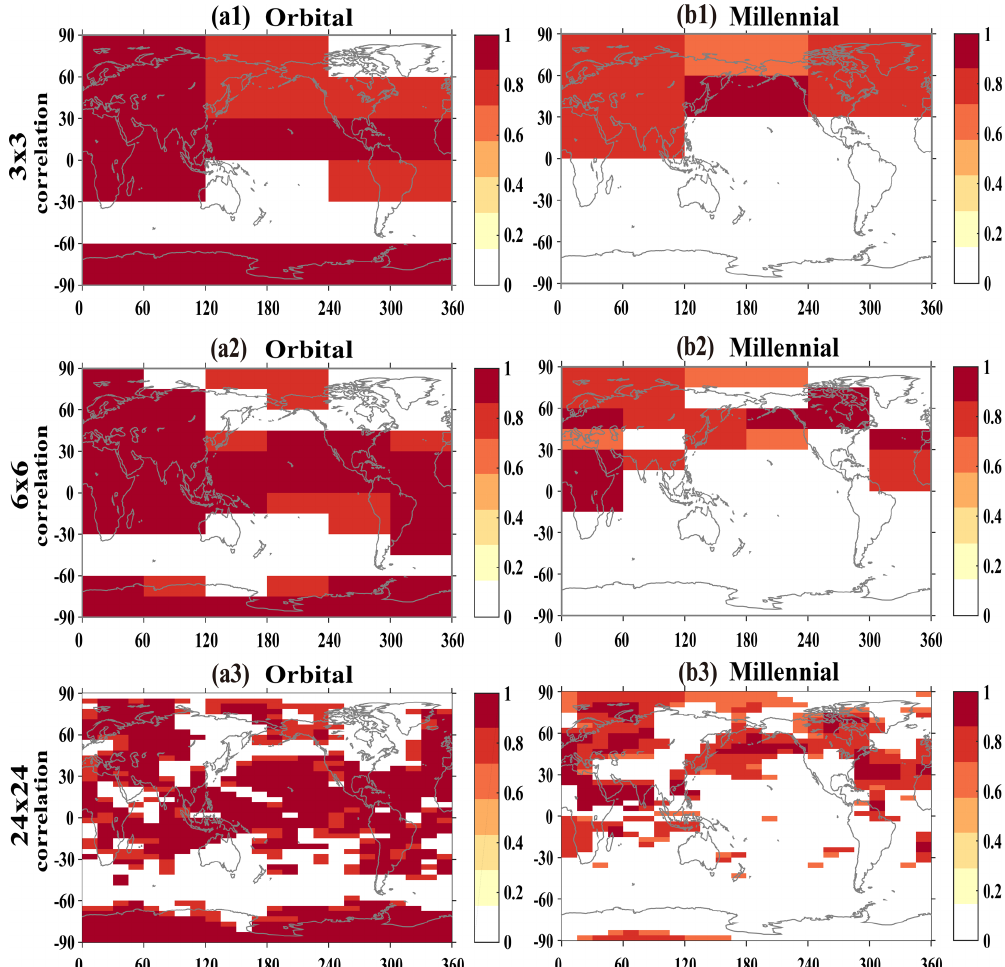
Figure 5. Correlation coefficient of mean surface temperature between the ALL and SUM outputs of the two timescales ( a1–a3 , orbital; b1–b3 , millennial) for three representative spatial scales: f = 3, 6 and 24 (the other factors are not shown because they are similar to the abovementioned three representative spatial scales). Only those regions significant at the 95% confidence level are shaded in